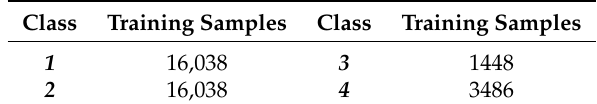
Table 4. Number of training samples in product change classification.